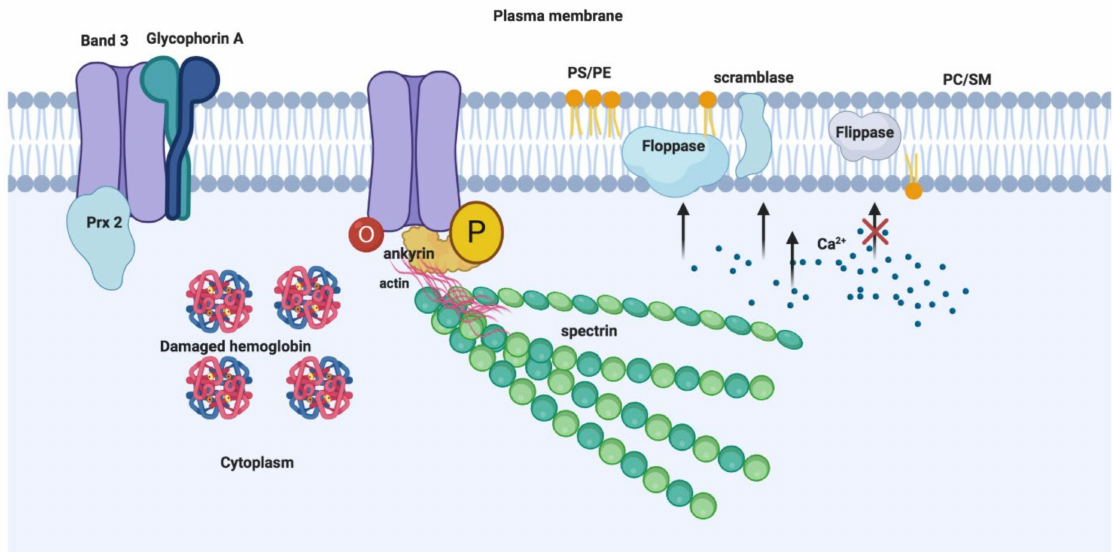
Figure 2. Mechanisms of RBC-MV biogenesis: MV generation on RBC membrane is predominantly triggered by damaged hemoglobin, protein oxidation, and senescence-associated degradation of band 3-cytoskeletal ankyrin association which result in evagination and vesiculation. Another mechanism involves the alterations in phospholipid distribution in lipid bilayer. Enzymes such as scramblase, calpain, and proteases are activated by oxidative damage or Ca 2+ influx via nonspecific cation channels leading to inhibition of flippase and phosphatidylserine externalization, cytoskeletal proteolytic degradation, and band 3 aggregation, resulting in vesiculation. Peroxiredoxin 2 (Prx-2) binding to N-terminal cytoplasmic domain of band 3, phosphorylation (P) and oxidation (O) of band 3 are also indicated [67]. (Figure created with